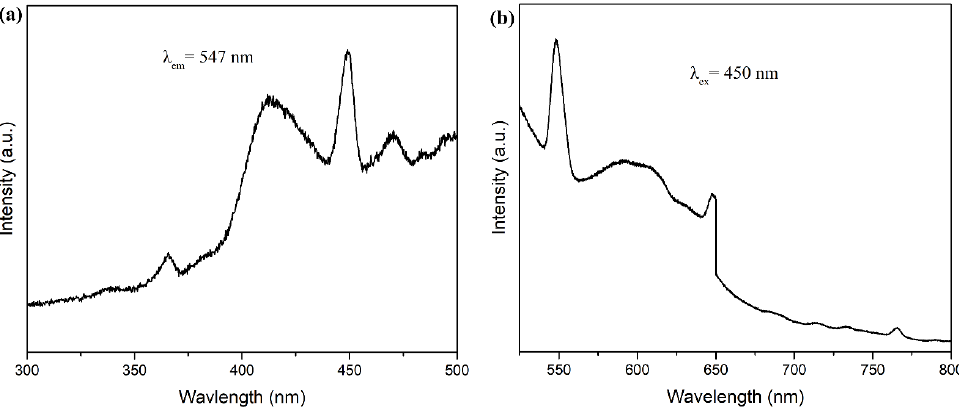
Figure 5. ( a ) Normalized PLE spectrum (λ em = 547 nm). ( b ) Normalized PL spectrum (λ ex = 450 nm).